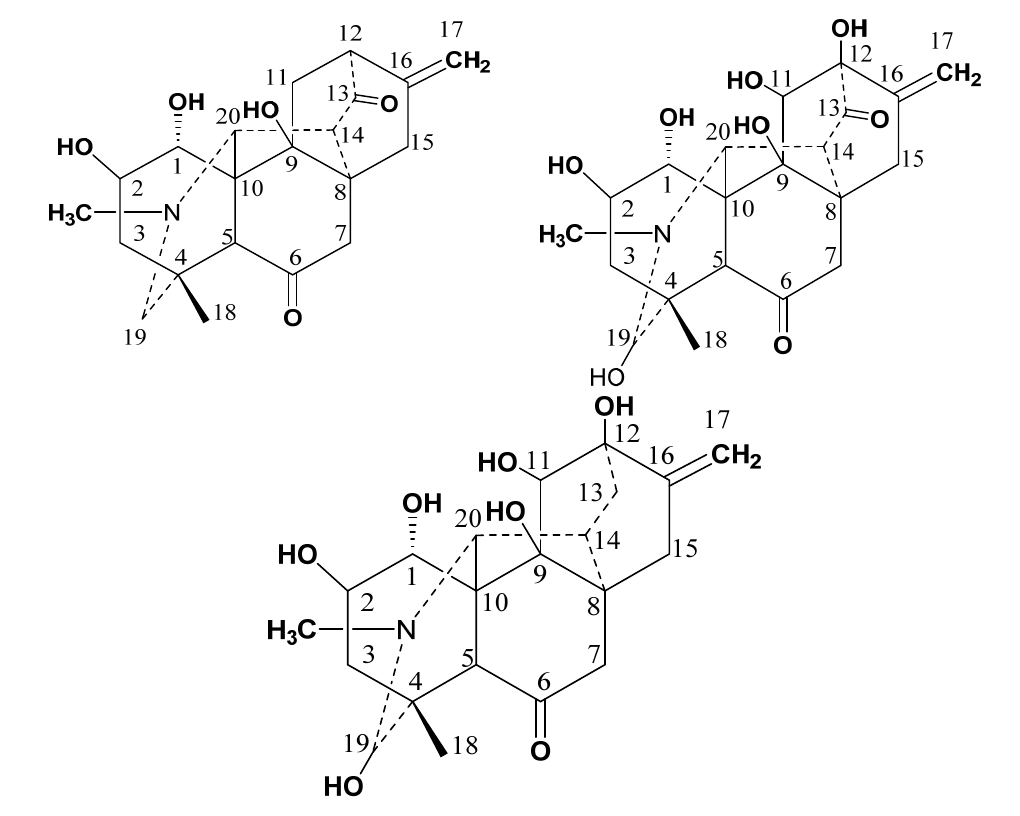
Figure 2. Structures of Compounds 1 – 3 .